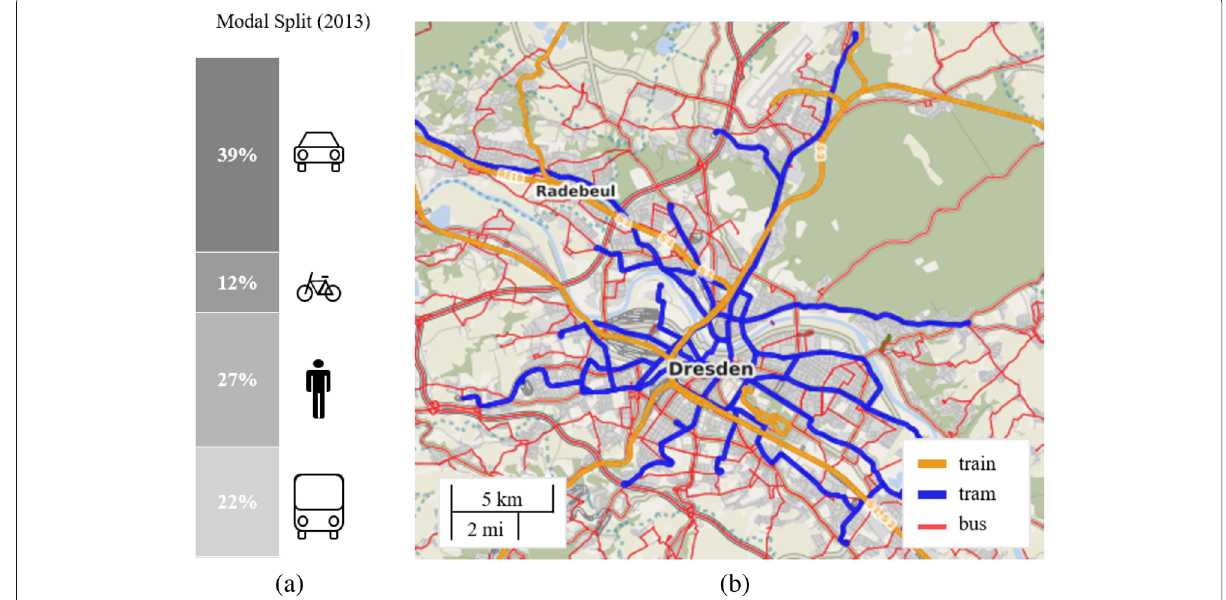
Fig. 1 a Modal Split and b Map of Dresden public